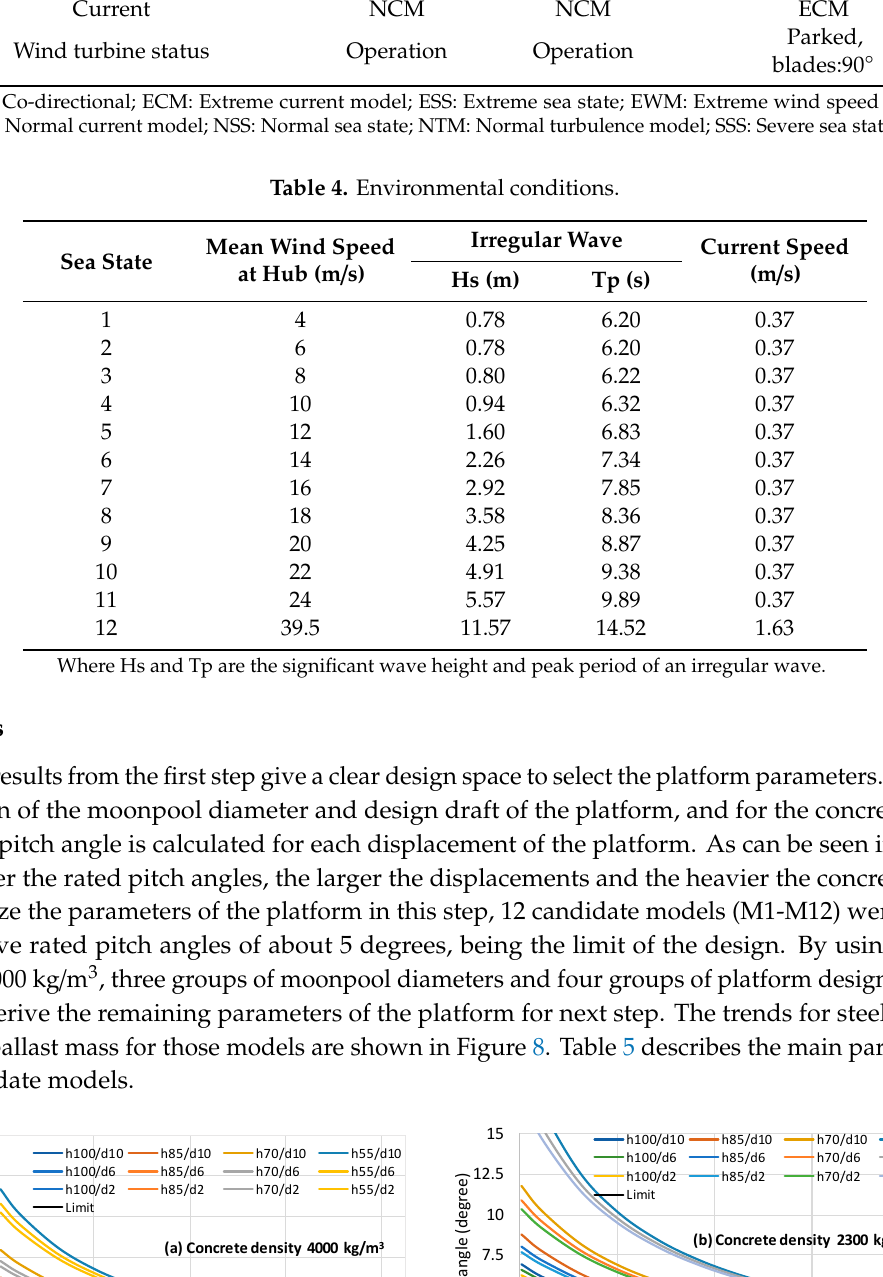
Figure 8. The trend of the mass distribution for steel and ballast mass.